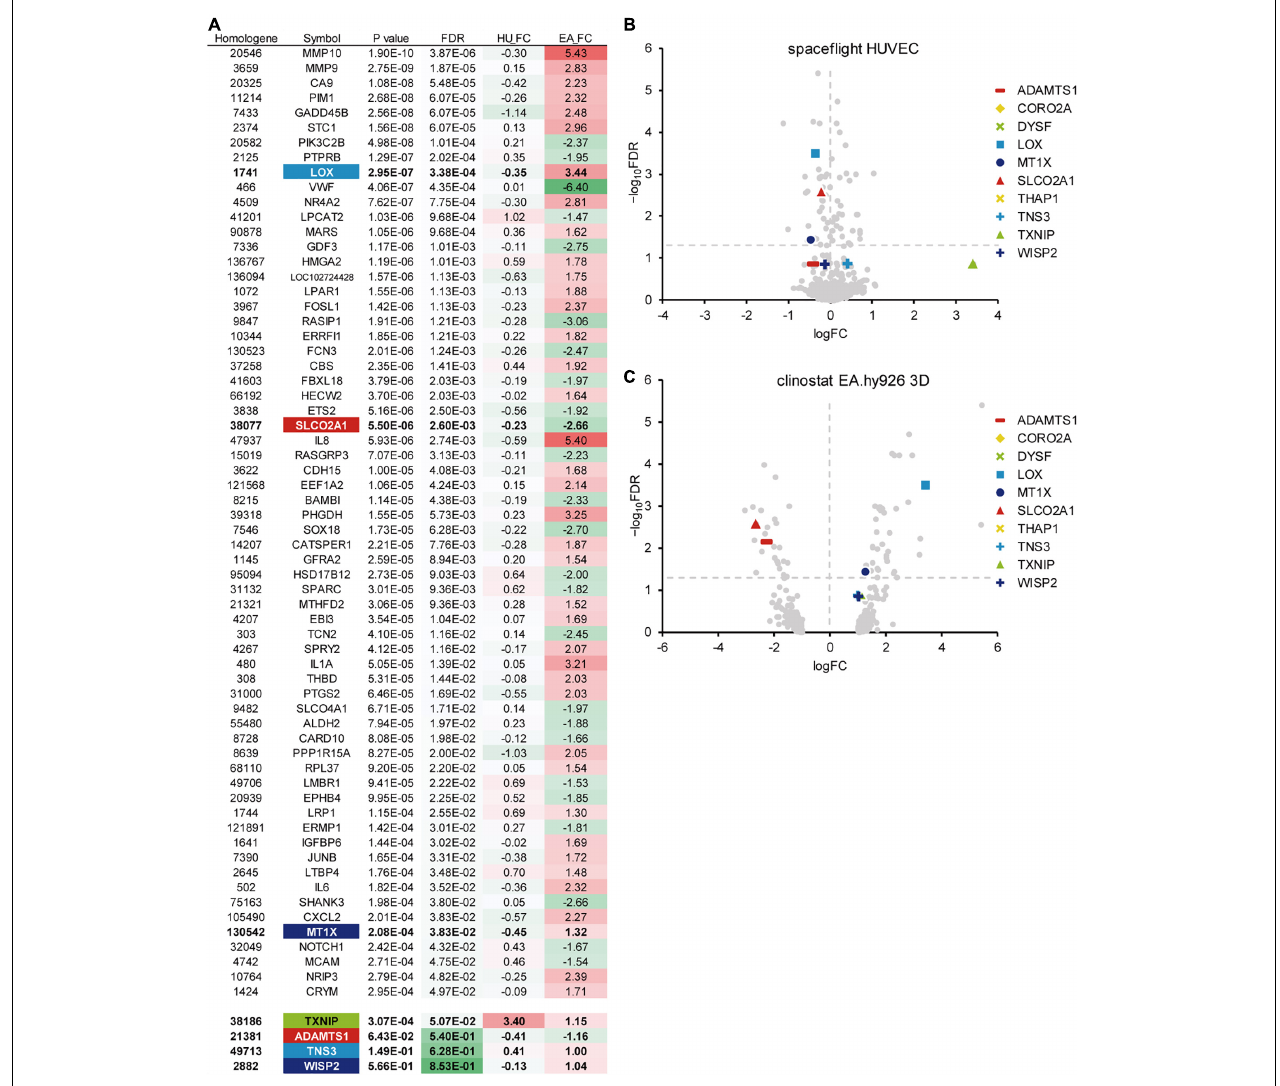
FIGURE 2 | A meta-analysis of gene expression in endothelial cells in response to other microgravity conditions. (A) Top 64 genes with the smallest p -values (FDR < 0.05), which were identified from the DNA array analyses of human umbilical vein endothelial cells (HUVEC) and EA.hy926 cells under spaceflight and simulated microgravity conditions, respectively. Additional genes with relatively low p -values were listed below the top 46 genes. HU_FC: Log fold change value in HUVEC, EA_FC: Log fold change value in EA.hy926 cell. (B) The Volcano plot of the space flight HUVECs. (C) The Volcano plot of the clinorotated EA.hy926 cells. Horizontal dotted line: a line at which FDR is equal to 0.05. Vertical dotted line: a line at which logFC is equal to